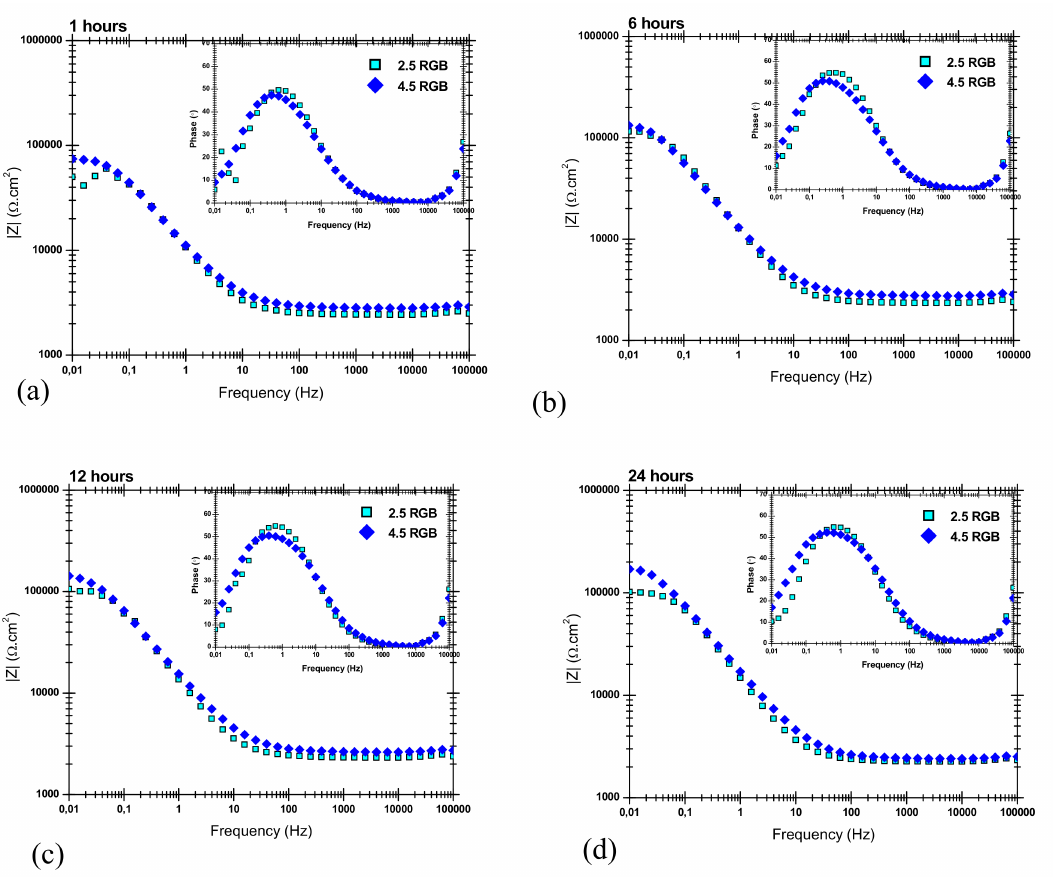
Figure 14. Bode plots of EIS spectra of samples 2.5 RGB, 4.5 RGB after ( a ) 1 h; ( b ) 6 h; ( c ) 12 h; and ( d ) 24 h of immersion in the diluted Harrison solution.